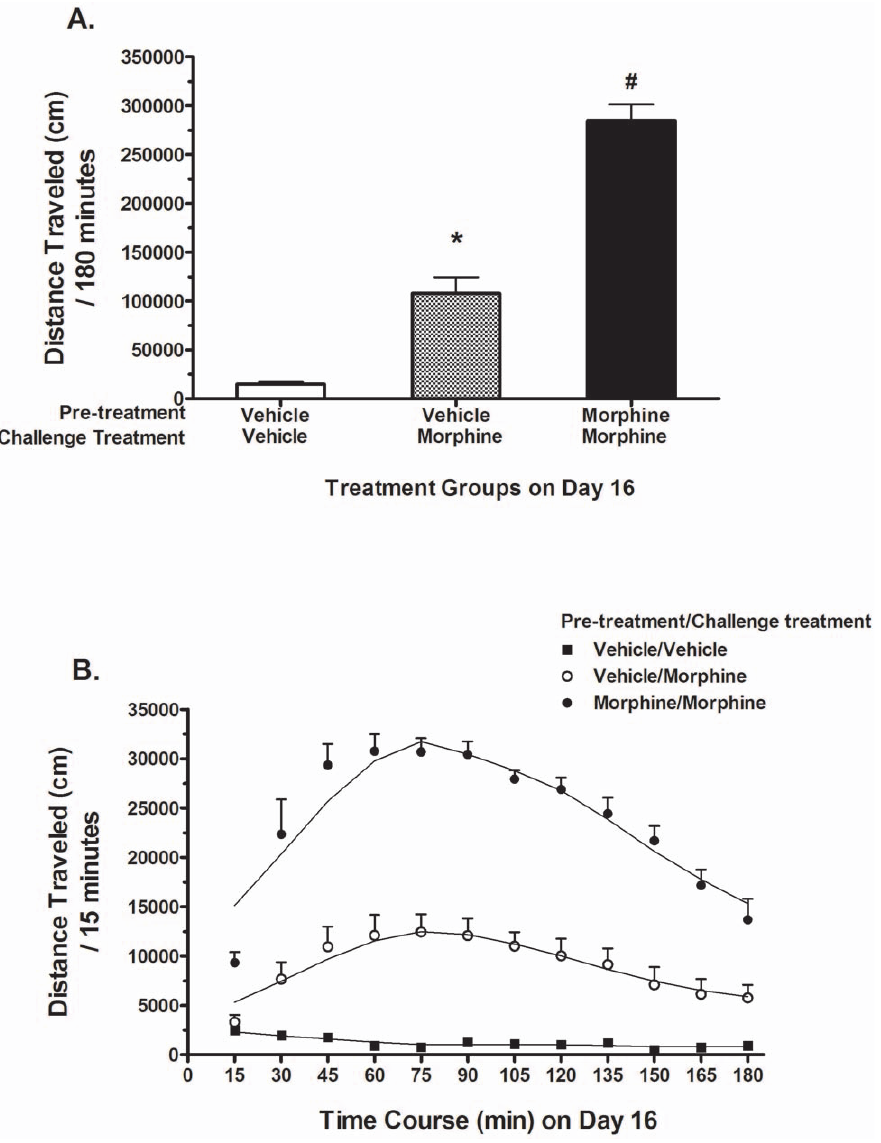
Figure 2. Intermittent morphine administration results in the expression of locomotor sensitization in C57BL/6 mice. A) Mice were given either a saline or morphine (10 mg/kg, s.c.) injection on days 1, 3, 5, 8, 10, and 12. On the challenge day (day 16), mice were treatment-free for a three day period and then received a single challenge dose of morphine (10 mg/kg) or saline. Locomotor activity tests were performed for 180 min immediately after drug injections and data are recorded as total distance traveled (cm) 6 S.E.M in each treatment group (n=8 mice per group). * P , 0.05 vs. vehicle pre-treatment/vehicle challenge group; # P , 0.05 vs. vehicle pre-treatment/morphine challenge group. B) The time course of opiate sensitization (measured in 15 min intervals) is demonstrated on challenge day after three treatment-free days from intermittent morphine administration on day 16.